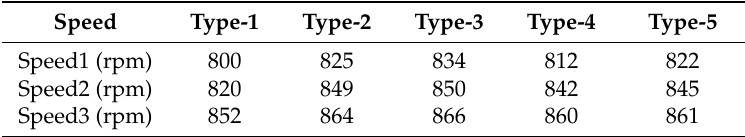
Table 2. Speeds of different fault types.